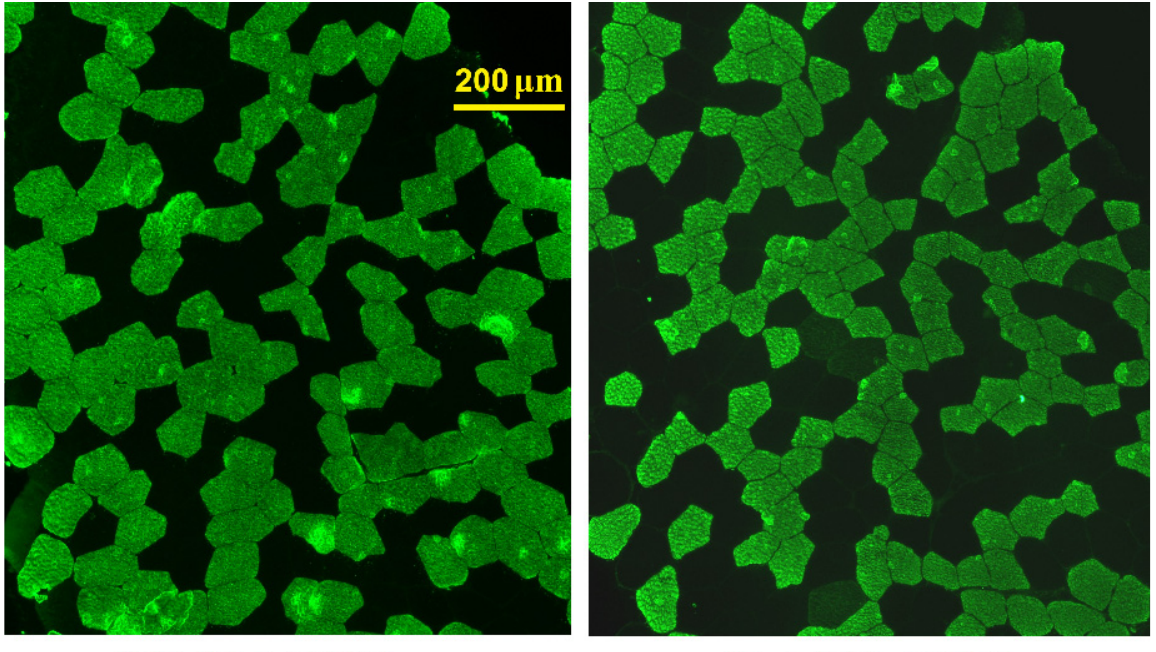
Figure 1. Microphotographs of the labelled muscle sections.